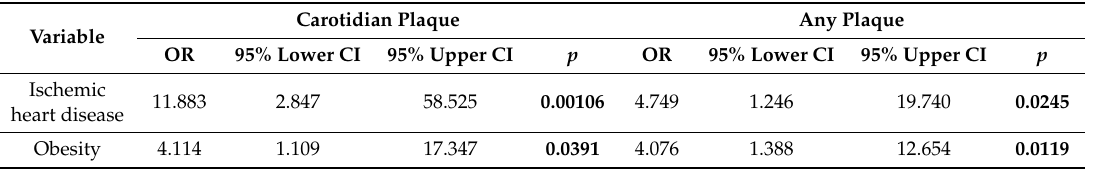
Table 3. Multivariate logistic regression for the significant variables that were selected from the univariate logistic regression model. p values were bolded if p <